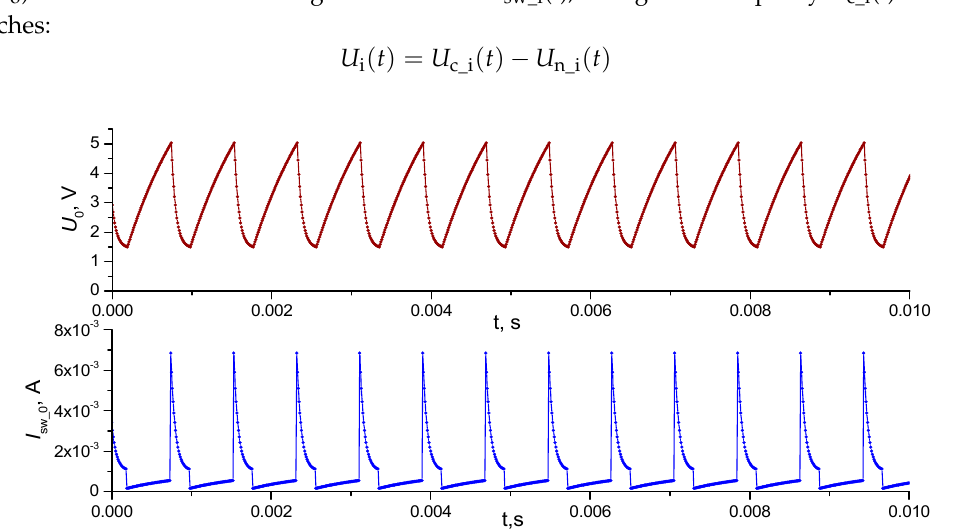
Figure A3. Examples of calculated oscillograms sections (1000 points), voltage U 0 and current I sw_0 , for the oscillator with i = 0 at I p_0 = 1200 µ A. Here we do not show other circuit parameters because other oscillators do not affect this one.